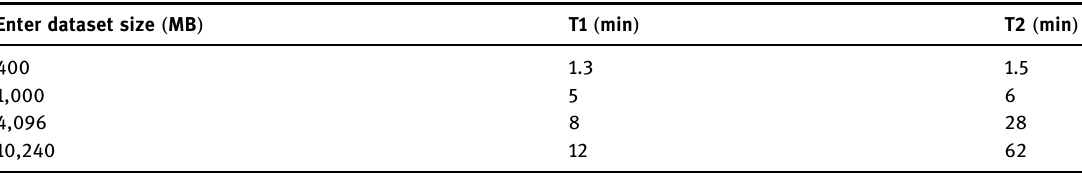
Table 2: E ffi ciency